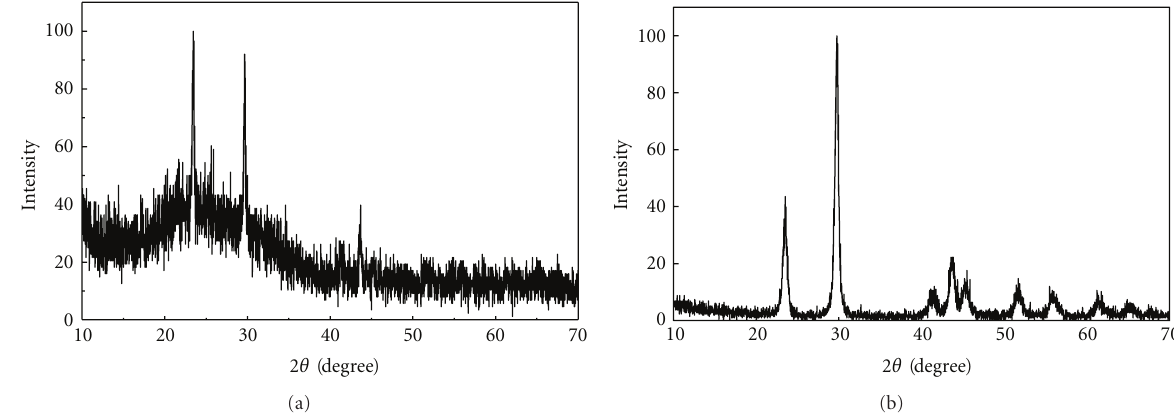
Figure 3: (a) XRD pattern of the synthesized selenium nanoparticles annealed at 130 ◦ C, for 6 hrs, and (b) commercial selenium sample. Selenium nanoparticles were synthesized by the reaction of 1 . 0 × 10 − 3 moldm − 3 sodium selenosulphate with 2 . 0 × 10 − 2 moldm − 3 acetic acid, in the presence of 0.01% PVA.